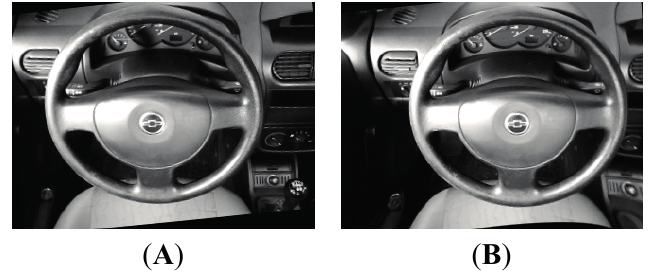
Figure 12. Image in stereo ( A ); Left not remapped ( B ) Right not remapped ( C ) Left remapped ( D ) Right